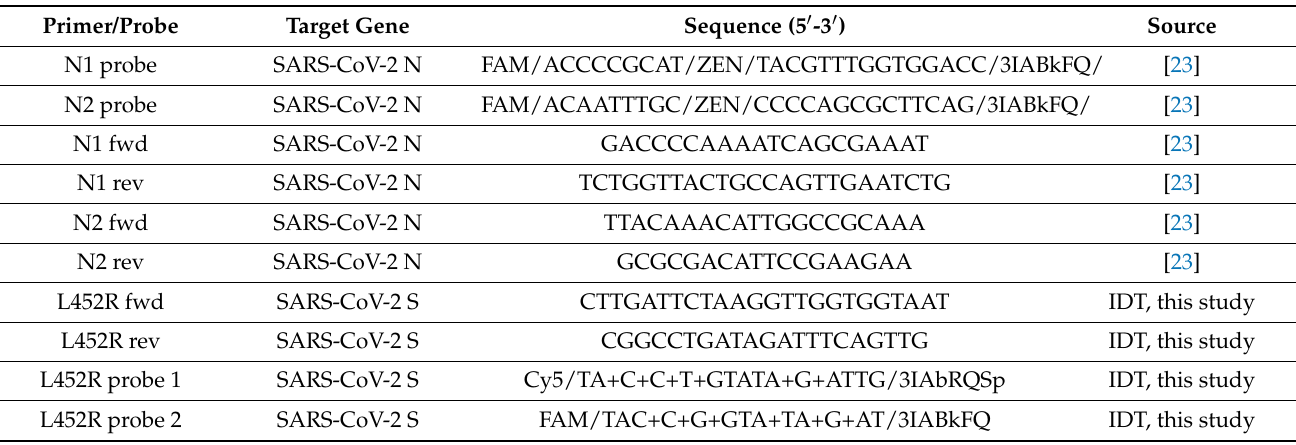
Table 2. Sequences of non-proprietary primers and probes used for SARS-CoV-2 detection. PMMoV, pepper mild mottle virus; IDT, purchased from Integrated DNA Technologies. “+N” indicates LNA positions. FAM, 5 (cid:48) 6-FAM (Fluorescein) modification; ZEN, internal quencher for fluorescence- quenched probes (IDT). 3IABkFQ, 3 (cid:48) Iowa Black FQ quencher; 3IAbRQSp, 3 (cid:48) Iowa Black RQ quencher; Cy5, 5 (cid:48) Cy5 fluorescence